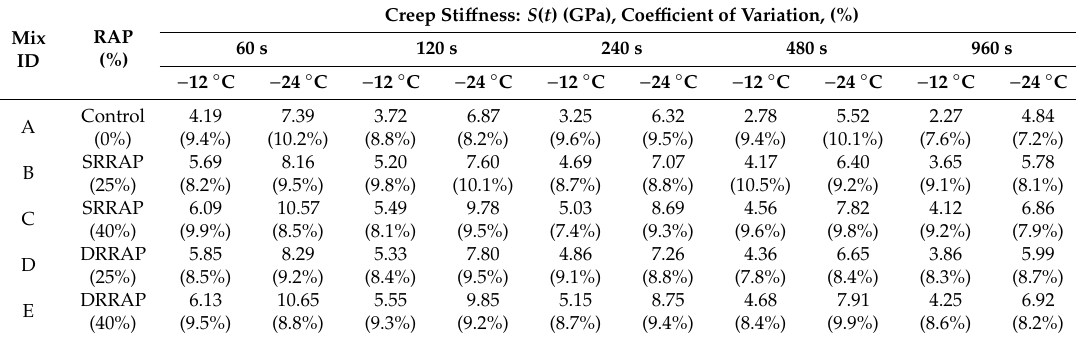
Table 3. Results of S ( t ) at t = 60, 120, 240, 480, 960